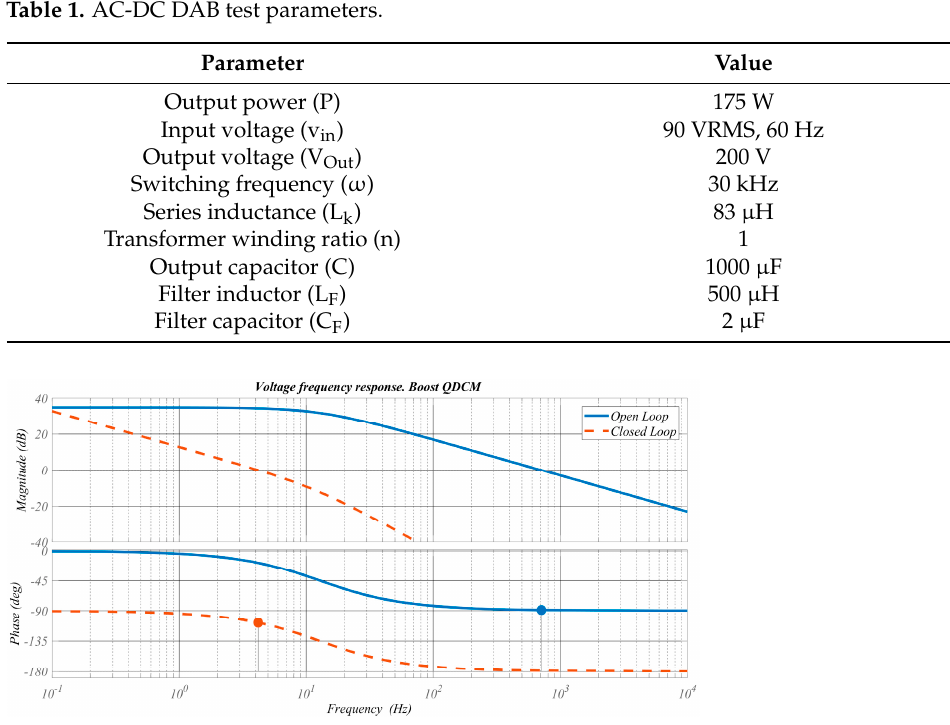
Figure 7. System frequency response in open loop and closed loop.